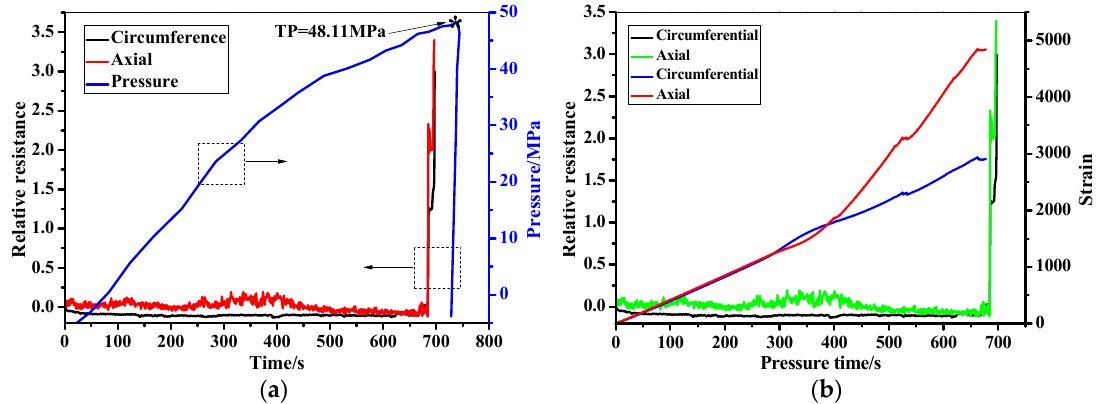
Strain change as a function of pressure. function of pressure.